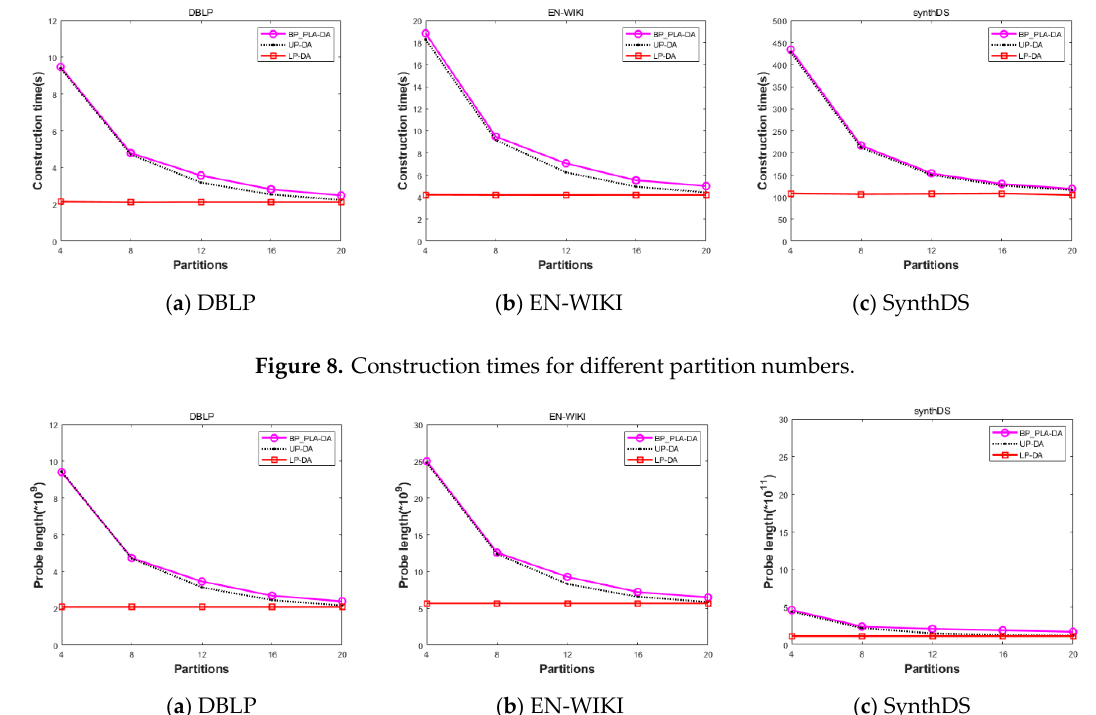
( b ) EN-WIKI ( c ) SynthDS Figure 11. Retrieval times for different number of strings. 4.2.3. Comparisons of Storage Spaces For the above indexes, the storage spaces are calculated as shown in Tables 3–5. Table 3. DBLP storage spaces (MB). String Numbers